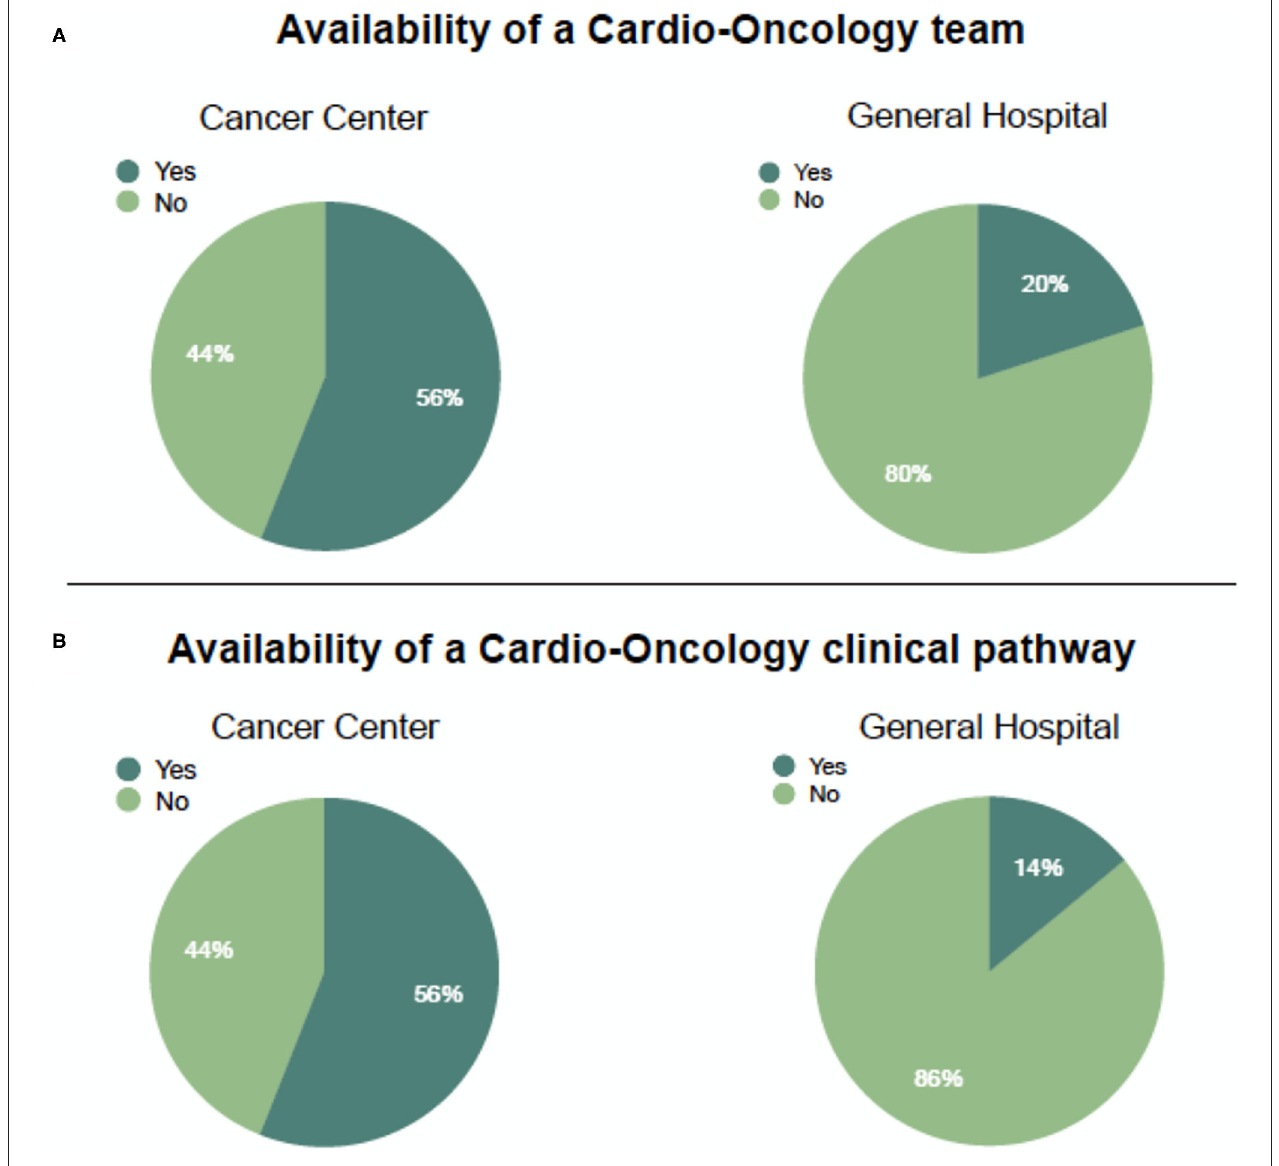
FIGURE 2 | Availability of a cardio-oncology team (A) and a dedicated clinical pathway (B) in Italian centers having completed the survey, divided by hospital